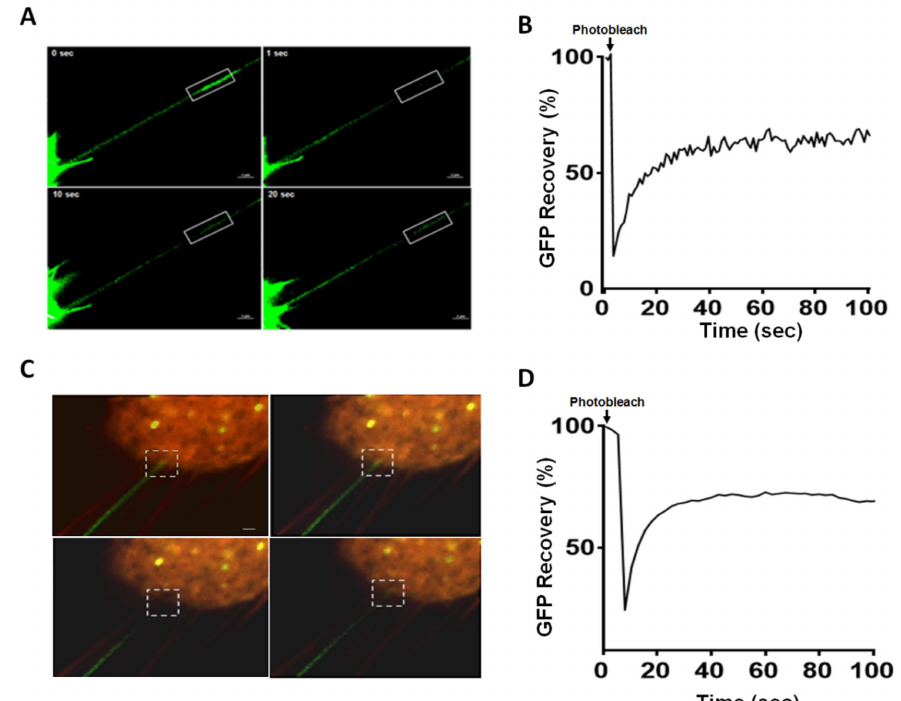
Figure 2. TNTs facilitate intercellular transfer and recipient cell entry of mutant KRAS . Photobleaching was performed 24 h after cells were placed in co-culture. Images were captured using a 60 × oil immersion objective lens of a Nikon A1Rsi confocal microscope. Scale bars = 2 µ m. ( A ) Fluorescence confocal microscopy and fluorescence photorecovery after bleaching (FRAP) analysis of GFP- KRAS G12D tra ffi cking within LOVO TNTs. GFP-tagged mutant KRAS transfected LOVO cells were co-cultured with CellTracker Red labeled HCT-8 cells; fluorescence confocal microscopy was performed to visualize recovery of fluorescent signals after photobleaching of the area indicated by the area in the rectangle. ( B ) Quantitation of fluorescence photorecovery of the area shown in panel A. The time point of immediate loss of GFP expression occurred at T = 0, after bleaching. GFP fluorescence intensity recovery is graphed as a percentage of initial expression. ( C ) Fluorescence confocal microscopy and FRAP of GFP- KRAS G12D visualized at the point of contact of the TNT with the plasma membrane of a recipient HCT-8 cell. The square dotted lines indicate the photobleached region at point of contact. ( D ) Quantitation of fluorescence photorecovery of the area shown in panel ( C